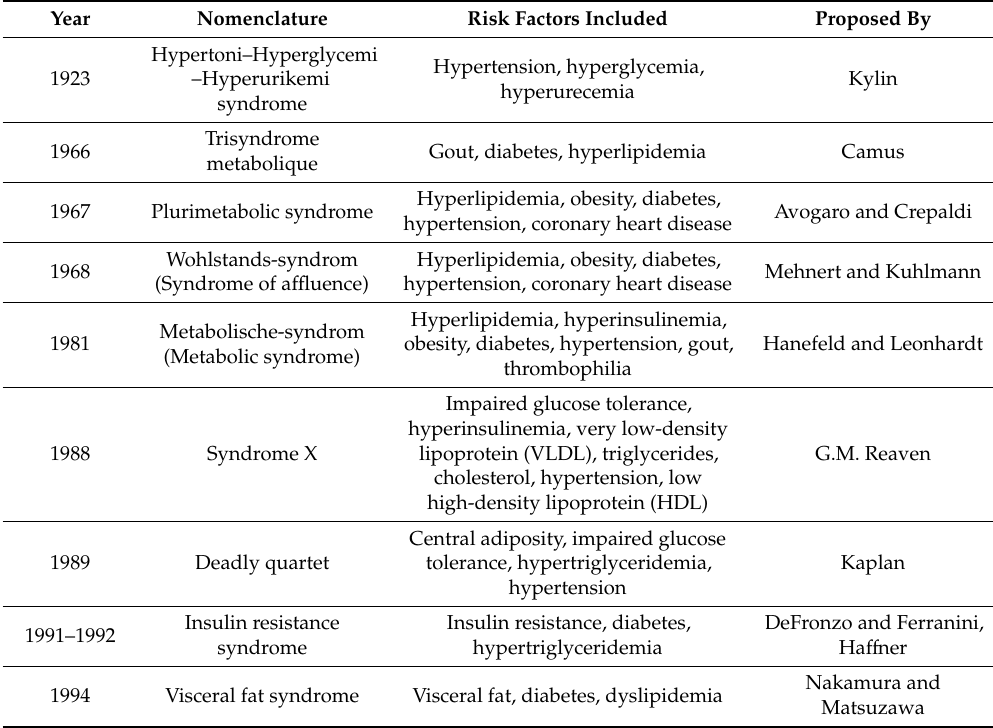
Table 1. Di ff erent nomenclature given to metabolic syndrome (MetS) conditions over the